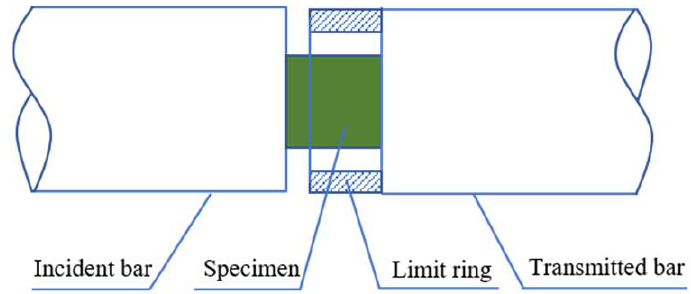
Figure 4. Diagram of the limit ring.